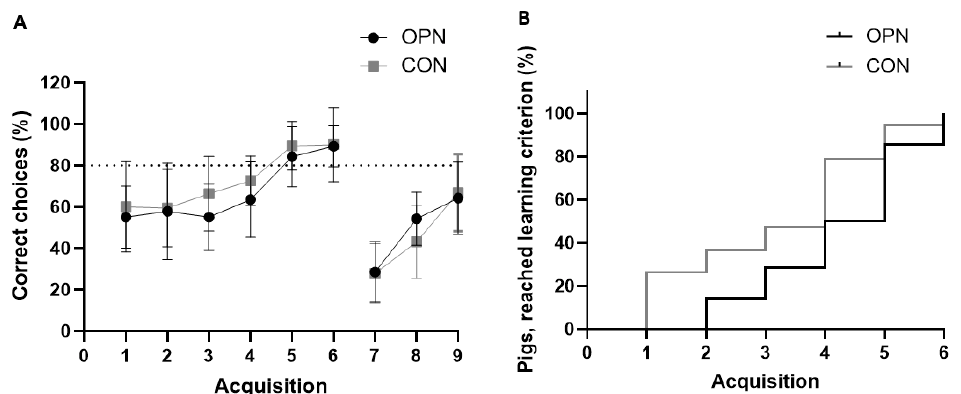
Figure 7. Cognitive performance during the spatial T-maze test. Proportion of correct choices ( A ) during the standard (Acquisitions 1–6) and reversal phase (Acquisitions 7–9) of preterm pigs fed a bovine milk diet (CON, n = 19) supplemented with bovine milk osteopontin (OPN, n = 14). The proportion of OPN and CON pigs reaching the learning criterion of 80% correct choices in the standard phase ( B ). Data are expressed as mean ± SD.